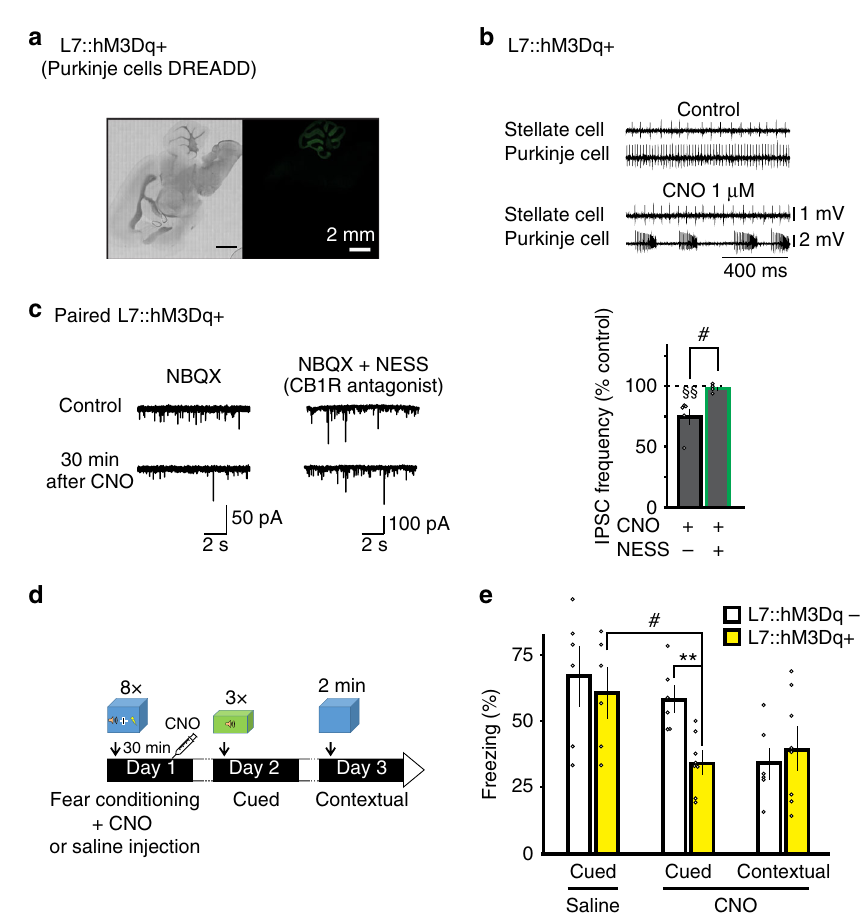
Fig. 8 Pharmacogenetic activation of Gq pathways in Purkinje cells in vivo after fear conditioning disrupts cued fear memory retention. a Bright fi eld and fl uorescence images of mCitrine from an L7::hM3Dq + mouse. b Paired extracellular recordings from a stellate and Purkinje cell before (top) and during (bottom) application of CNO. c Left, representative traces of IPSCs recorded from stellate cells before (top) and 30 min after (bottom) CNO application ( n = 5 cells). Center, NESS 0327 was present throughout the experiment ( n = 4 cells). Right, effects of CNO on IPSC frequency in stellate cells normalized